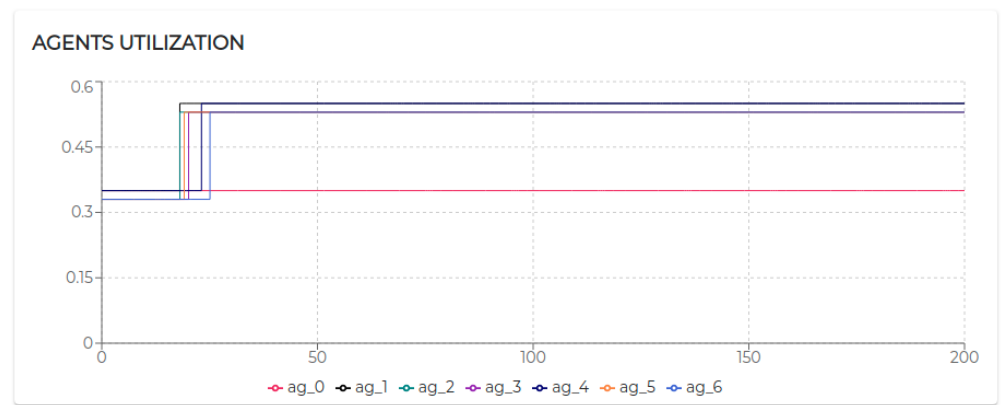
Figure 13. Agents utilization over the simulated time [0–200 s] in scenario S2; y-axis: utilization (adimensional); x-axis: time (seconds).